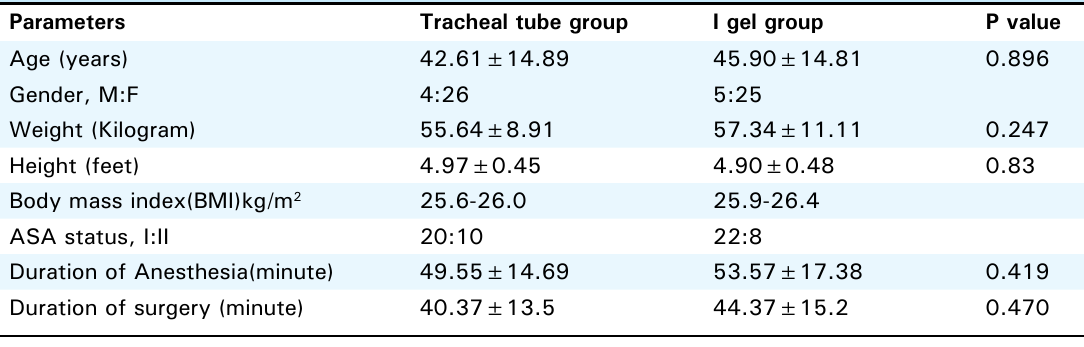
Table 1. Patient’s demographic characters, ASA physical status and duration of anesthesia and surgery (number ± Standard Deviation).